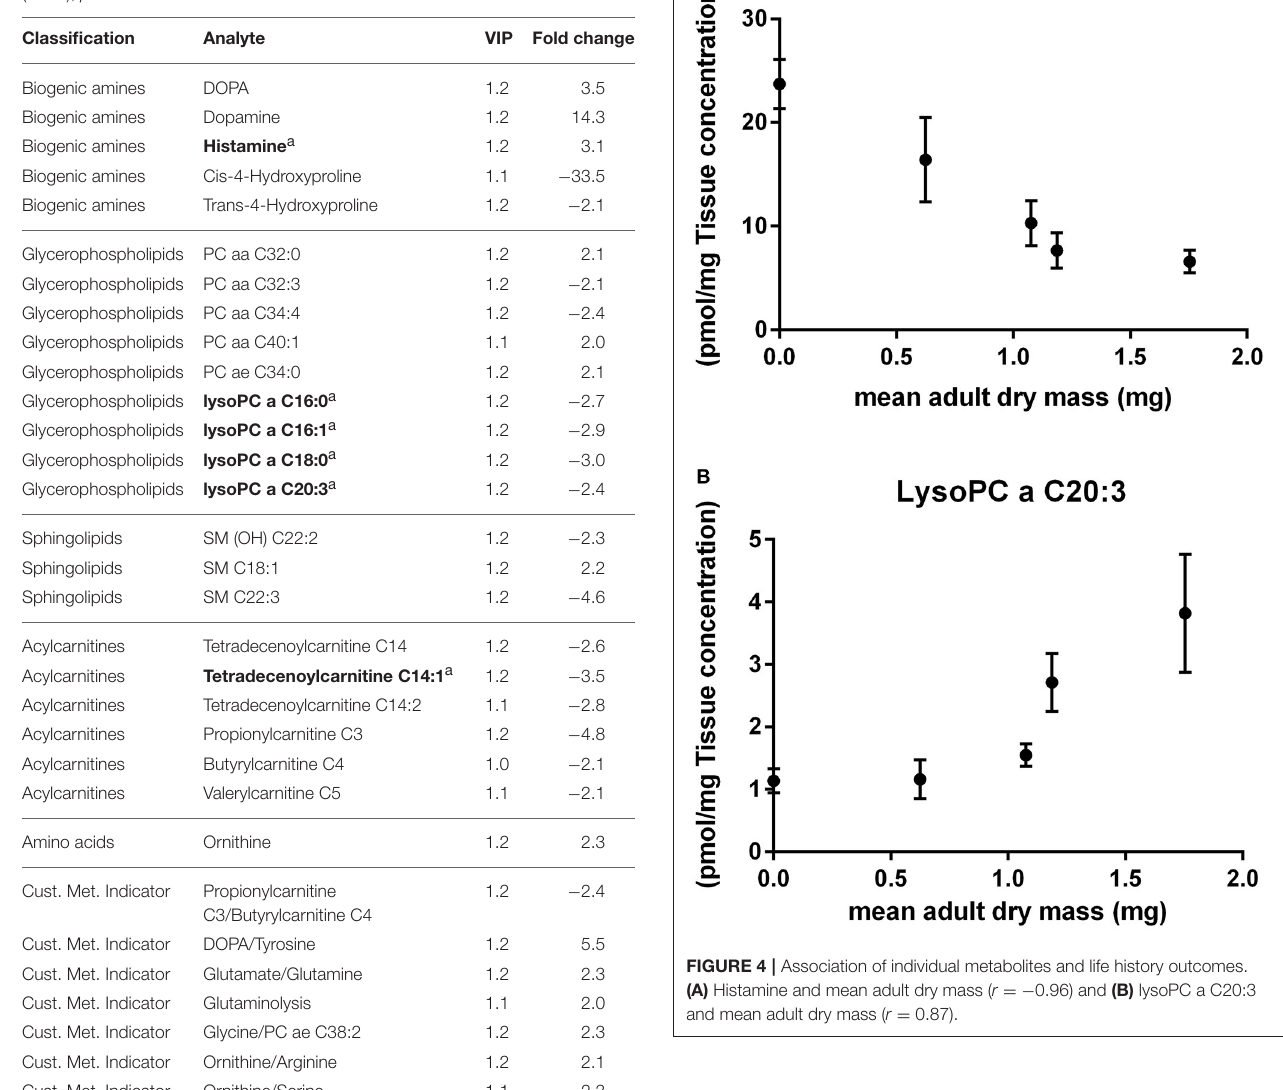
TABLE 3 | List of metabolites identified with VIP and fold change value to have significantly changed at chronic thermal stress (30 ◦ C) when compared to control (24 ◦ C), p < 0.05.